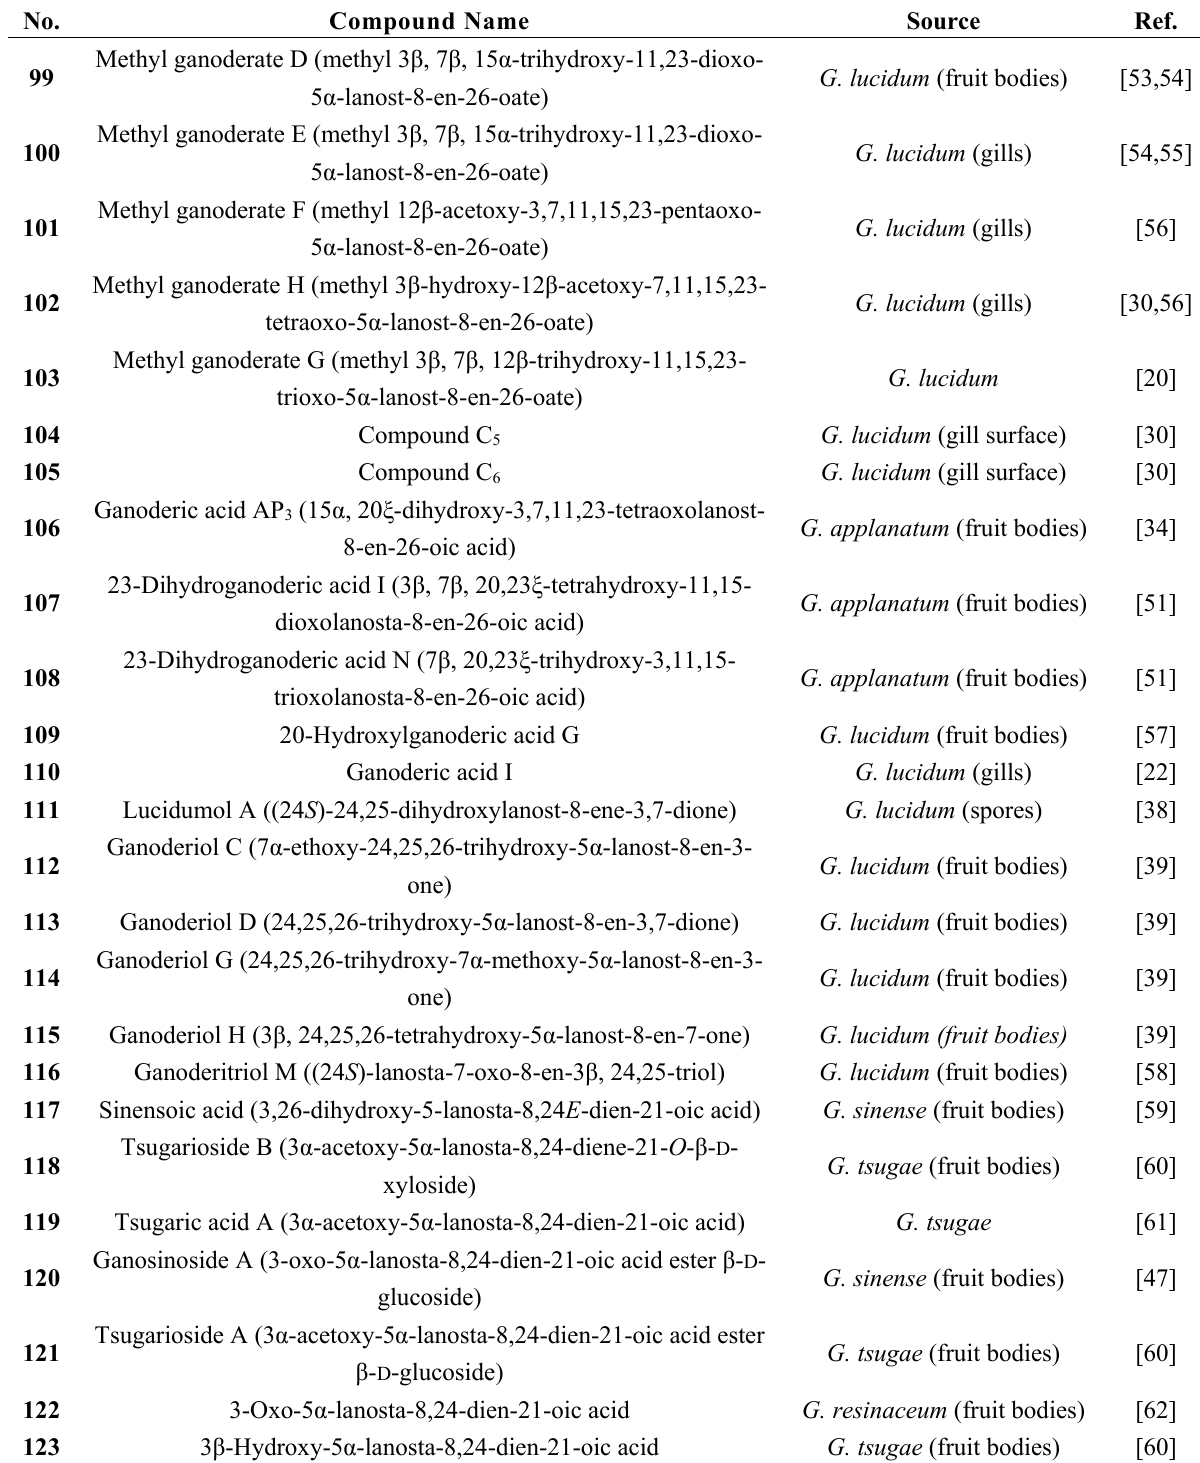
Table 4. Ganoderma triterpenes 99 – 123 in Figures